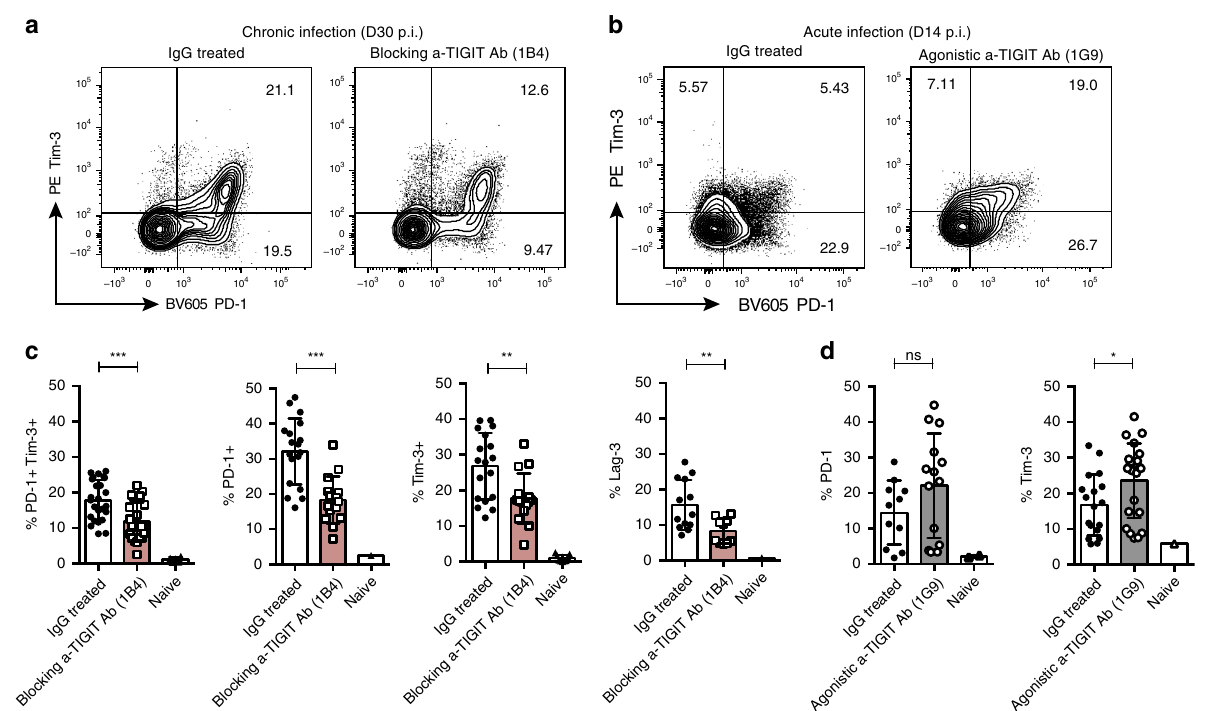
Fig. 2 In vivo TIGIT modulation alters co-inhibitory receptor expression on T cells after LCMV infection. C57BL/6 mice were infected with either 2 × 10 6 FFU LCMV clone 13 i.v. (red, chronic) or 1 × 10 5 FFU LCMV clone 13 i.v. (gray, acute) and treated with 100 μ g of blocking anti-TIGIT Ab (1B4, chronic infection), agonistic anti-TIGIT Ab (1G9, acute infection), or mouse IgG1 i.p. Representative FACS plots ( a , b ) and summary data ( c , d ) of co-inhibitory receptor expression on splenic CD8 + T cells after ( a , c ) chronic LCMV infection (day 30, n = 10-25), and ( b , d ) acute LCMV infection (day 14, n = 11 – 22) are shown. Data represent pooled data from four to fi ve independent experiments. Each symbol in the scatter plot represents an individual mouse, and bar graphs indicate the mean value ± SD. Statistical values p < 0.05 (*), p < 0.01 (**), p < 0.005 (***), or ns (not signi fi cant, p > 0.05) determined by Welch ’ s t